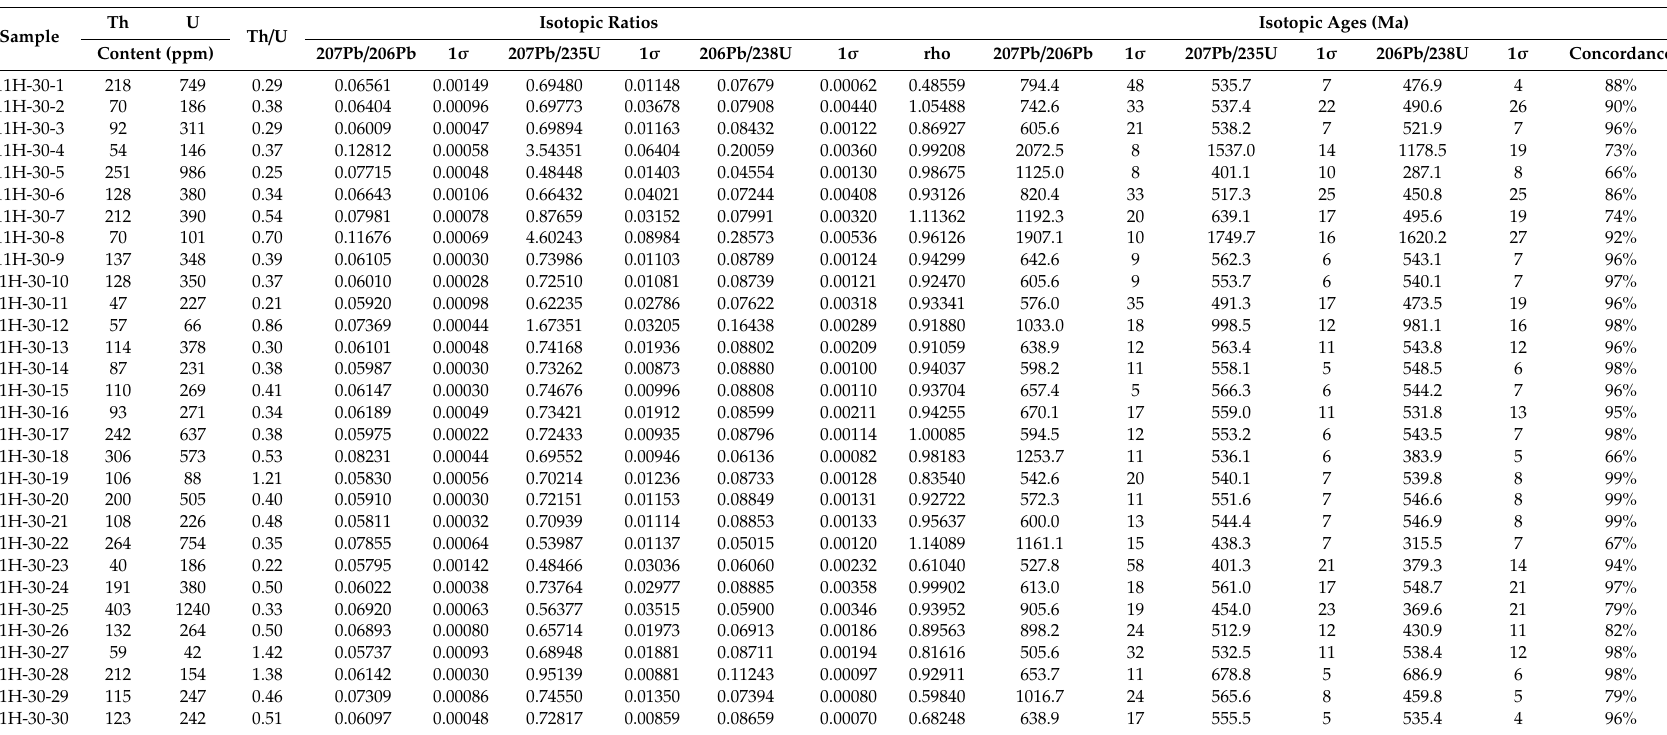
Table 2. LA–collector inductively plasma (ICP)–mass spectrometer (MS) zircon U–Pb isotopic data for representative samples of biotite granites from the Gaudeanmus study